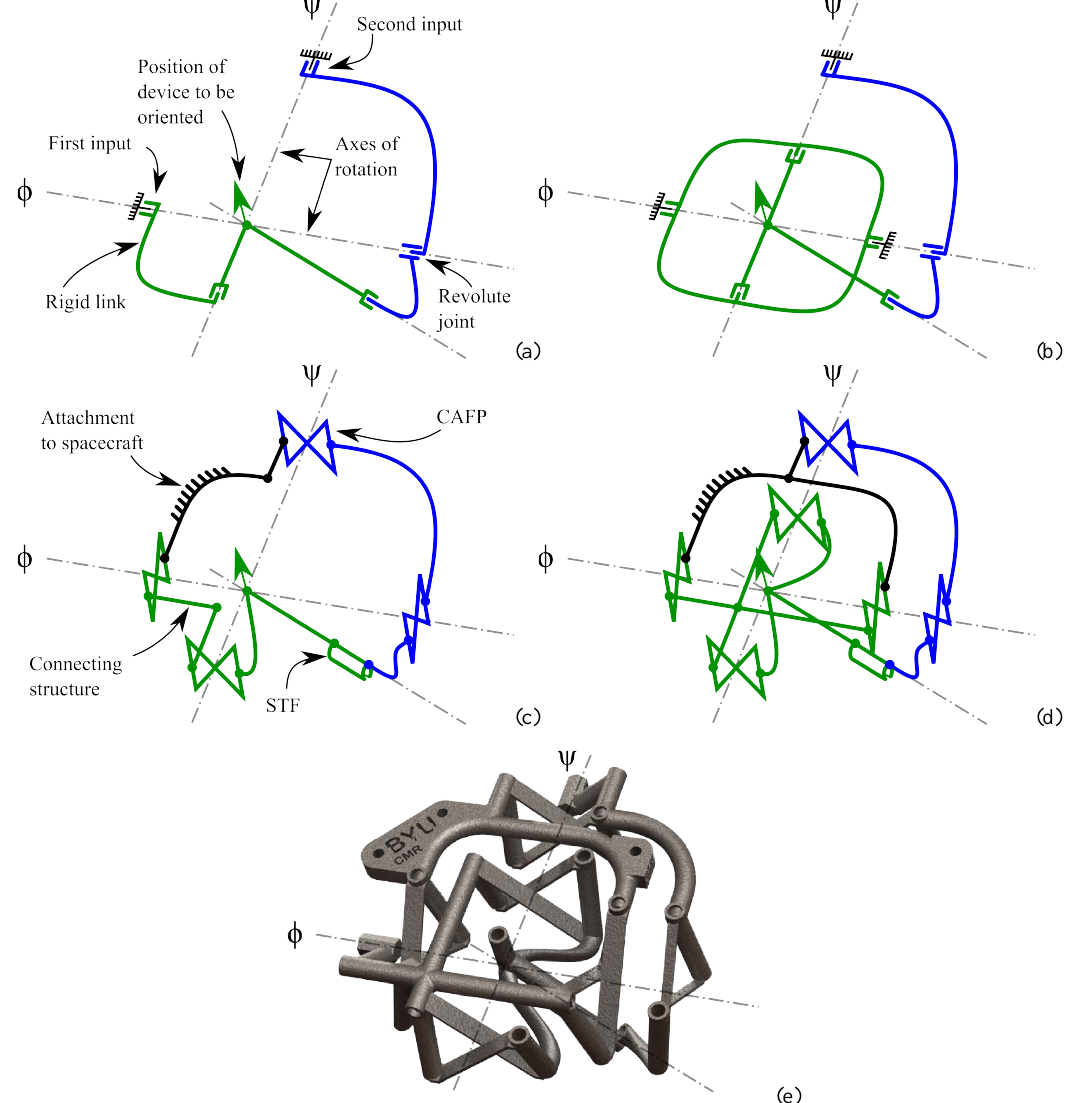
Figure 2. Rigid body replacement for the spherical five-bar mechanism. (a) Rigid link representation. The arrow is located at the intersection of the axes of the spherical mechanism and represents the mechanism to be oriented. (b) Symmetry added to increase sti ff ness under load. (c) Basic mechanism with CAFPs and a STF. (d) Representation of full mechanism. (e) Rendering of CAD